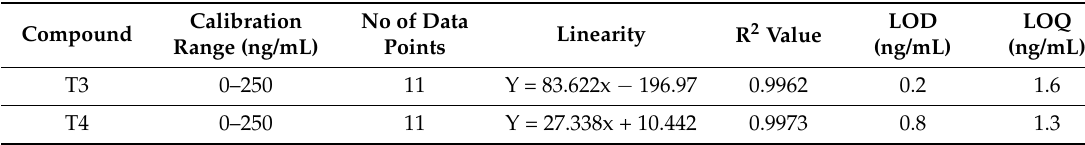
Table 1. Analytical data for T3 and T4 by LC–MS/MS.